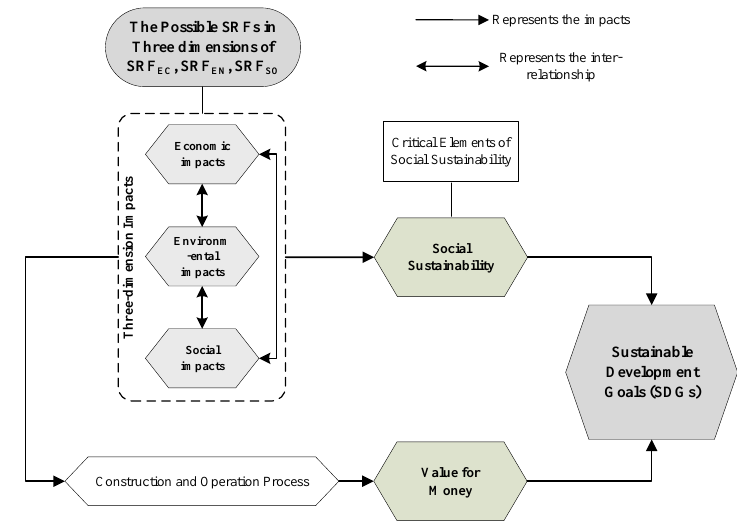
Figure 3. The conceptual model for SRFs in this study.